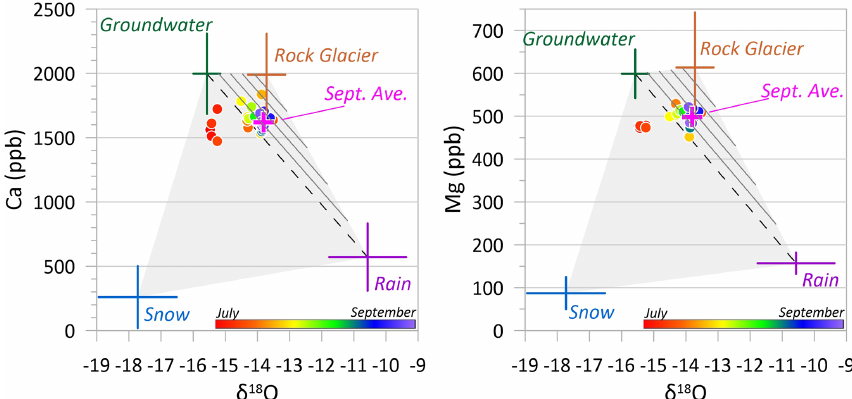
Figure 11. Biplots of δ 18 O vs. Ca and Mg used to determine the contribution of rock glacier discharge to streamflow. Water in the stream is plotted with a rainbow pattern progressing from July (red) through to early October (purple). Crosses represent the end members of snow, rain, groundwater, and rock glacier water. July streamwater samples contain a mixture of snowmelt and groundwater, but in August and September, snowmelt is no longer detectable (samples to right of dashed line). Streamwater samples at this time contain non-trivial amounts of water derived from rock glaciers, with an average of 25% in September (pink cross). Diagonal black lines denote the abundance of rock glacier water in increments of 20% for